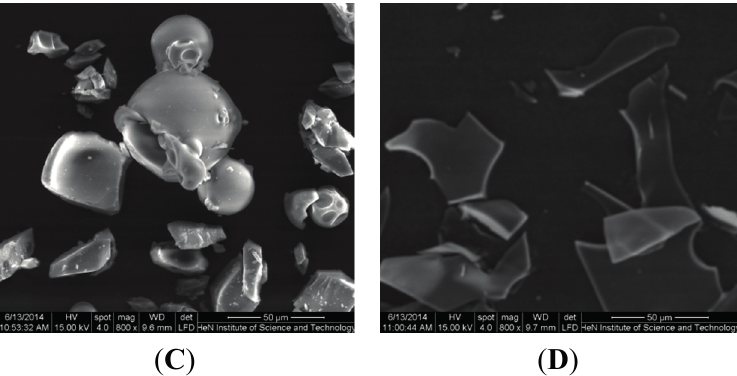
Figure 3. Scanning electron micrographs of ( A ) ILTG, ( B ) G 2 - β -CD, ( C ) the ILTG/G 2 - β -CD physical mixture, and ( D ) the ILTG/G 2 - β -CD inclusion complex.